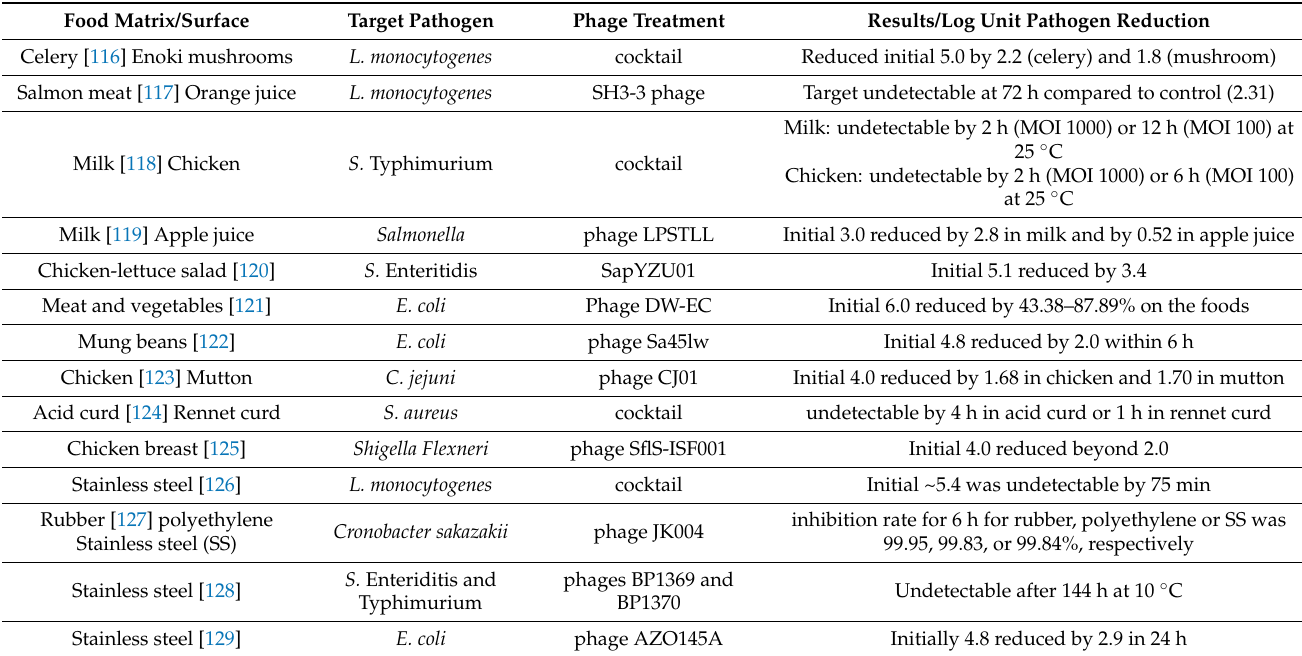
Table 3. Summary of phage studies in food matrices and surfaces.